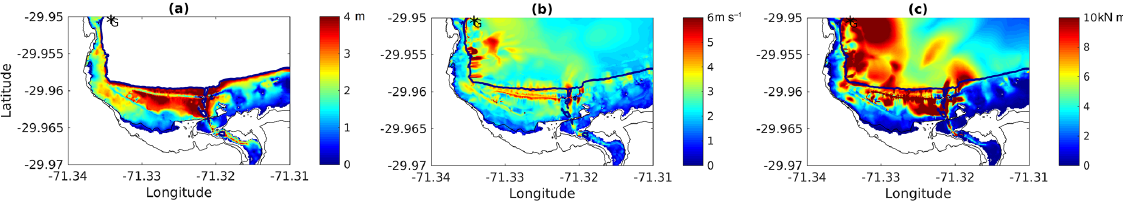
Figure 7. Results of tsunami numerical simulations for each intensity measure. (a) Inundation depth, (b) flow velocity and (c) hydrodynamic force.